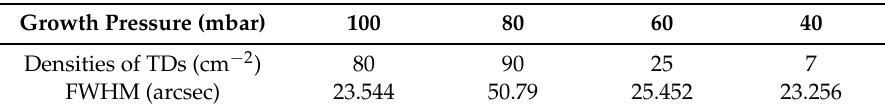
Figure 6. Dislocation densities of epitaxial layers grown at different pressures.